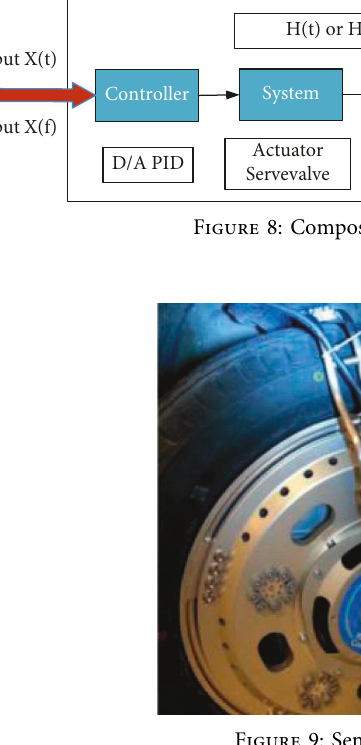
Figure 9: Sensor installation.